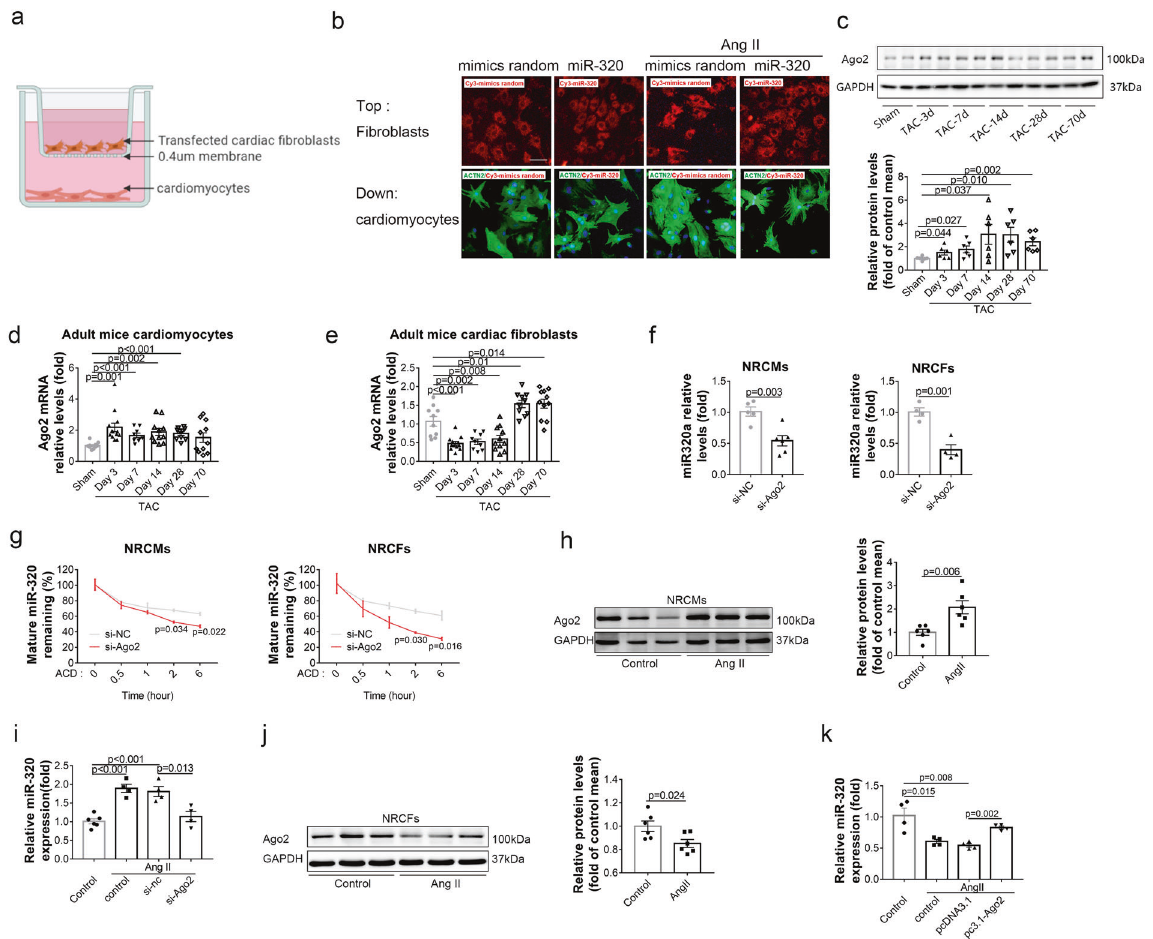
Fig. 5 The different expression patterns of miR-320 were governed by Ago2. a Schematic diagram of co-culture assay. Top well, NRCFs; lower chamber, NRCMs. b NRCFs in the top chamber were photographed by fl uorescence microscope after transfected with Cy3-labeled miR-320. ACTN2 staining of NRCMs in the lower chamber. Scale bar, 100 µm. c Protein expression levels of Ago2 and GAPDH in mouse hearts after TAC (left). Quantitative analysis of Ago2 protein levels after normalization to GAPDH (right). d Ago2 mRNA levels in CMs at different time points after TAC were measured by real-time PCR. Sham ( n = 10), TAC-Day 3 (n = 13), TAC-Day 7 ( n = 9), TAC-Day 14 ( n = 11), TAC-Day 28 ( n = 10), and TAC-Day 70 ( n = 11). e Ago2 mRNA levels in CFs at different time points after TAC were measured by real-time PCR. Sham ( n = 10), TAC-Day 3 ( n = 12), TAC-Day 7 ( n = 9), TAC-Day 14 ( n = 11), TAC-Day 28 ( n = 10), and TAC-Day 70 ( n = 11). f Relative miR-320 levels in si-Ago2 treated NRCMs (left, n ≥ 3) and NRCFs (right, n ≥ 3). g Mature miR-320 levels detected by real-time PCR after actinomycin D treatment, normalization to GAPDH in NRCMs (left, n = 4) and NRCFs (right, n = 4). h Protein expression levels of Ago2 and GAPDH in NRCMs with Ang II treatment (left). Quantitative analysis of Ago2 protein levels after normalization to GAPDH (right). i MiR-320 expression levels in NRCMs with different treatments were measured by real-time PCR ( n ≥ 3). j Protein expression levels of Ago2 and GAPDH in NRCFs with Ang II treatment (left). Quantitative analysis of Ago2 protein levels after normalization to GAPDH (right). k MiR-320 expression levels in NRCFs with